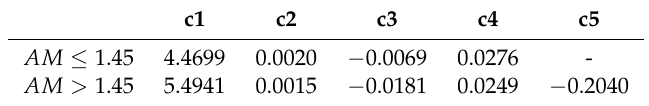
Table 3. Linear coefficient of the production Hybrid model adopted in this